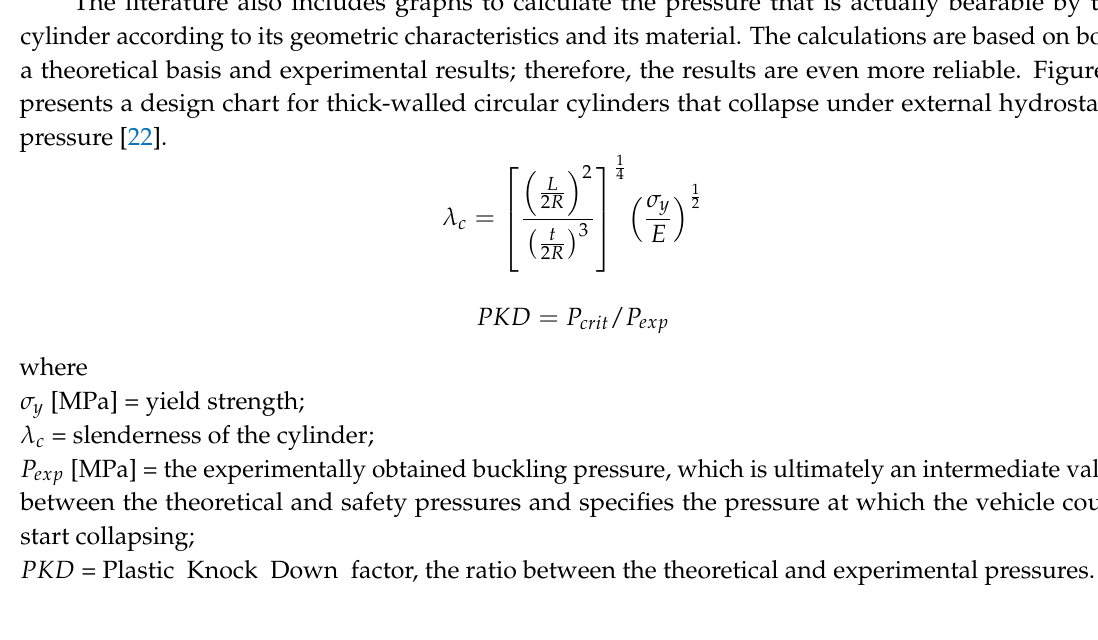
Figure 6. Predicted buckling pressure versus tube length [23].